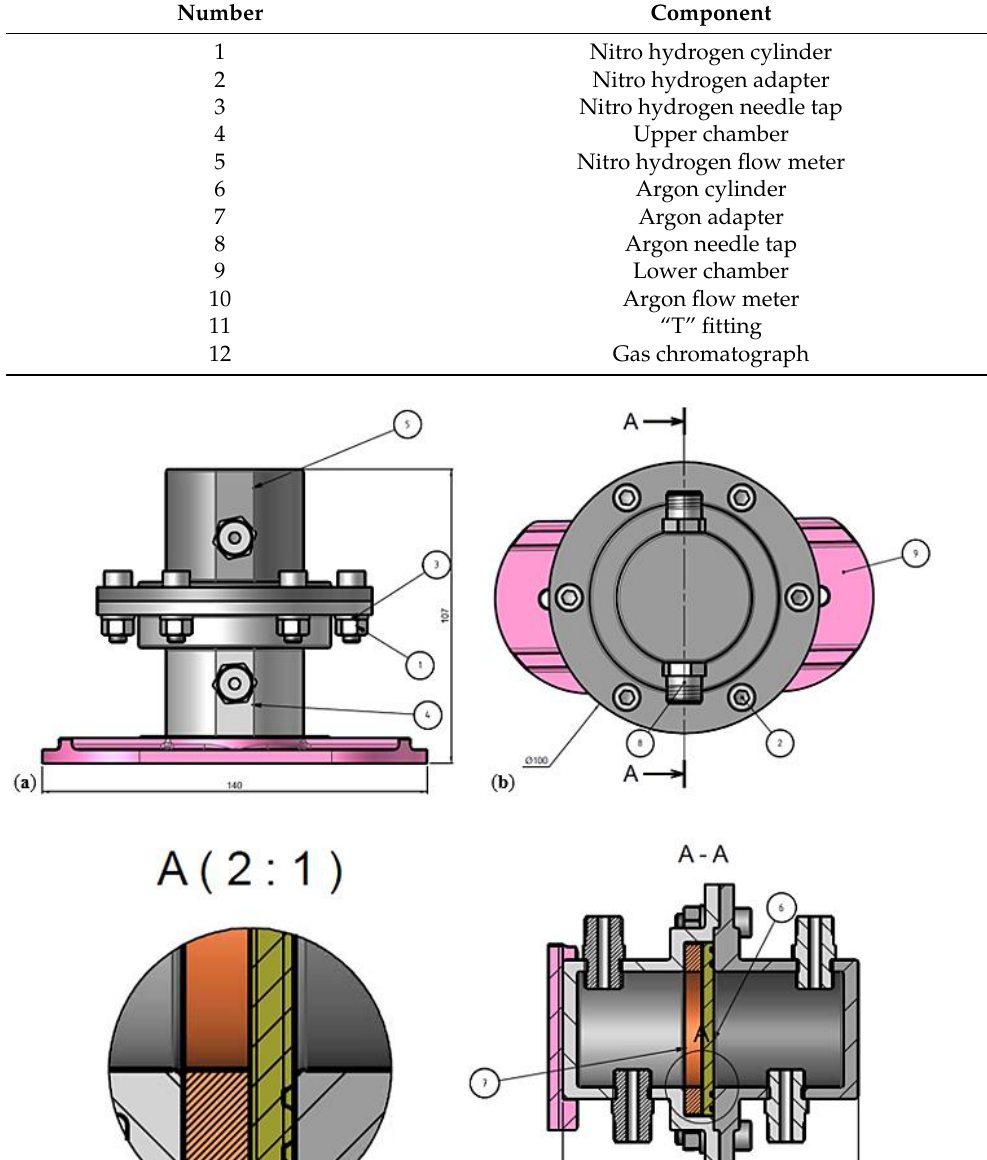
Table 1. Legend of hydrogen permeability test bench.